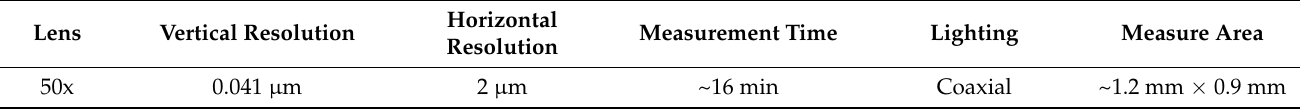
Table 1. Topography measurement parameters with the InfiniteFocus G5 device.